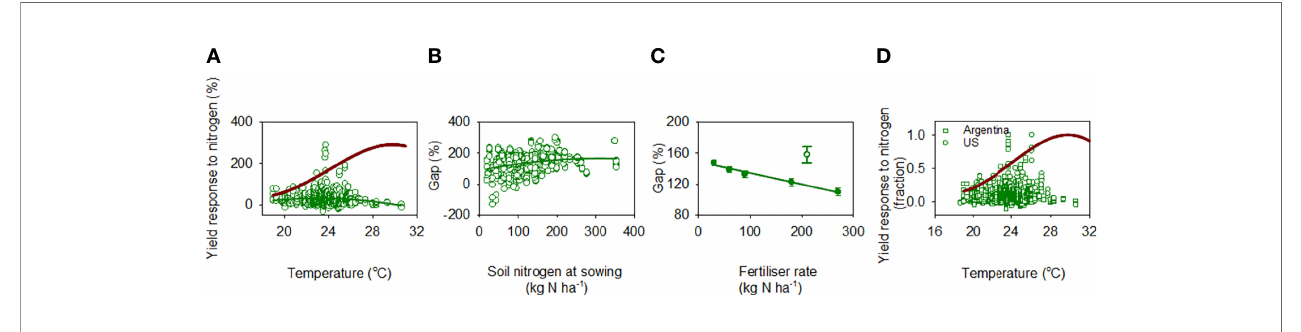
FIGURE 8 | (A) Yield response to nitrogen as a function of mean air temperature in the critical period for rainfed maize in Argentina. Response to nitrogen is: 100 · (Y N - Y 0 )/Y 0 where Y is yield, and subscripts indicate fertilised (N) and unfertilised control (0). The green line is a quadratic model fi tted to the data. The red line is the 3-trait boundary de fi ned as a function of duration of the critical period, canopy carbon exchange rate and ear-to-biomass ratio ( Figure 7C ), scaled to the actual maximum. (B) Gap between boundary and actual yield response to nitrogen as a function of soil nitrogen at sowing. (C) Average (± s.e.) gap between boundary and actual yield response to nitrogen as a function of fertiliser rate. The open symbol is a small sample of crops with 210 kg N ha -1 , which was not included in the regression. (D) Actual yield response to nitrogen as a function of temperature in the critical period for 1756 crops in Argentina and US against the 3-trait